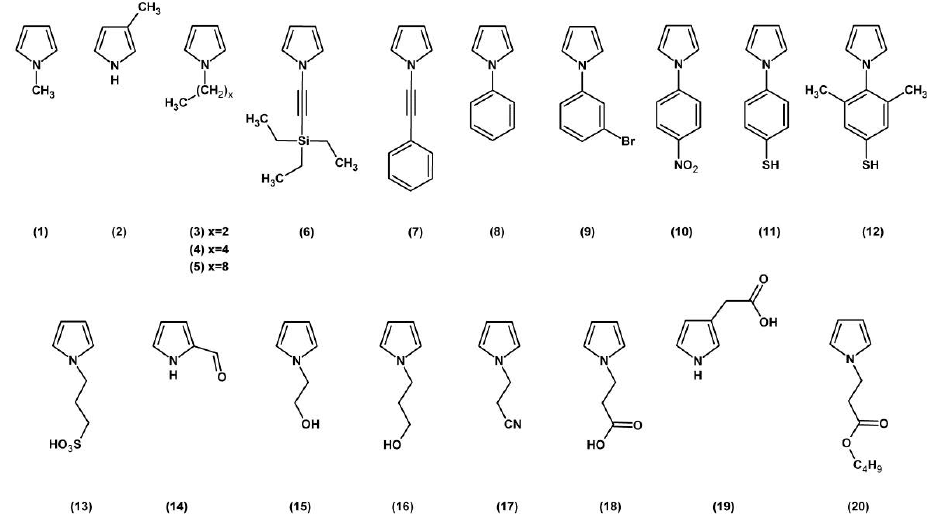
Figure 1. Chemical structures of pyrrole derivatives 1 – 20 used as co-monomers for electrochemi- cal